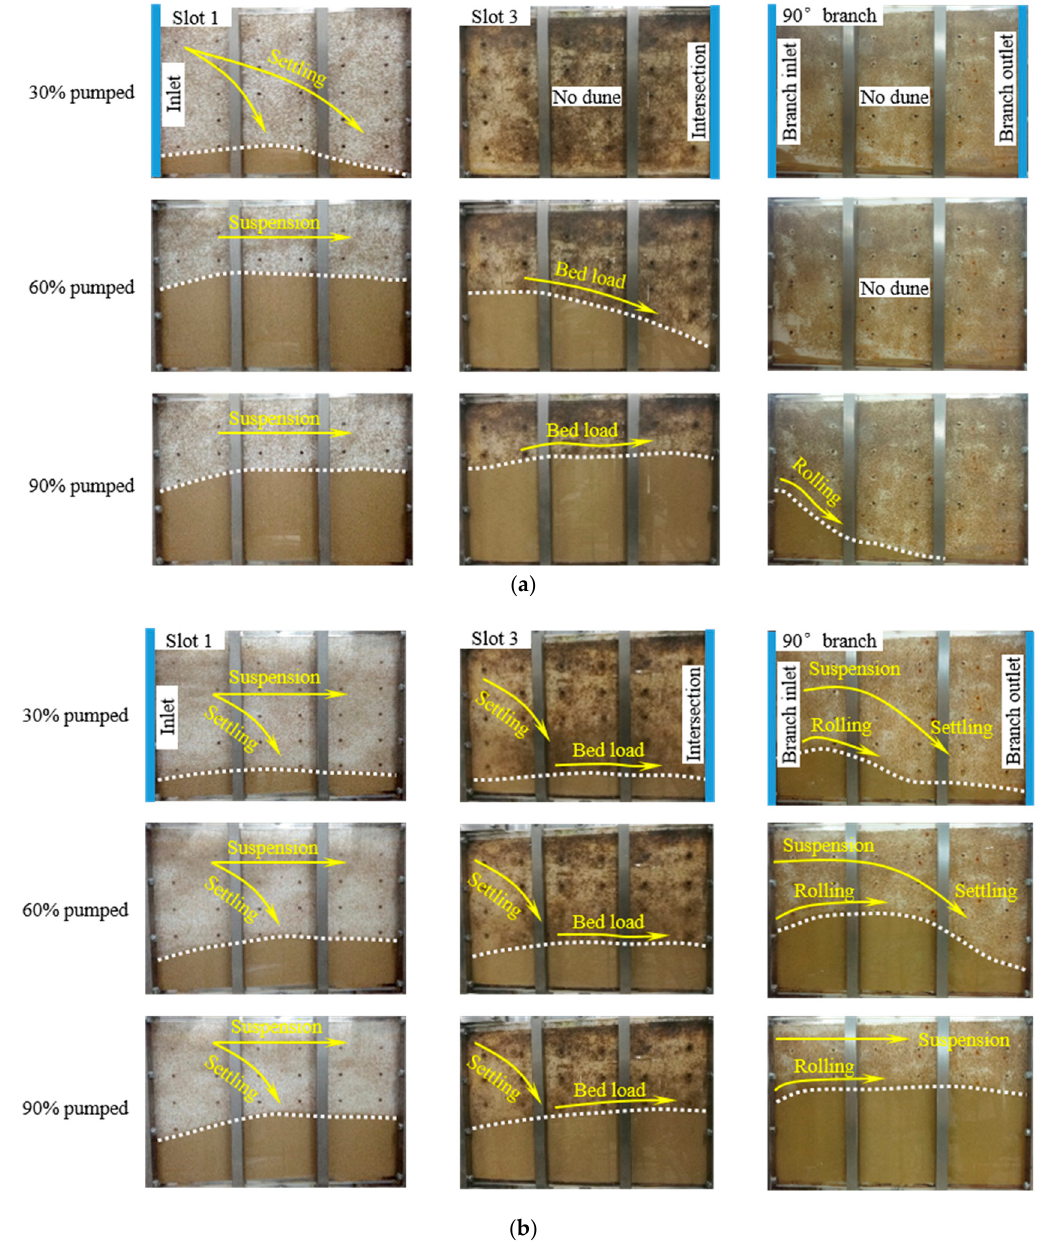
Figure 3. Pattern of dune development in the branch, ( a ) the branch dune development is dependent on the dune in the primary fracture for case 1, ( b ) the branch dune development is independent on the dune in the primary fracture for case 4.